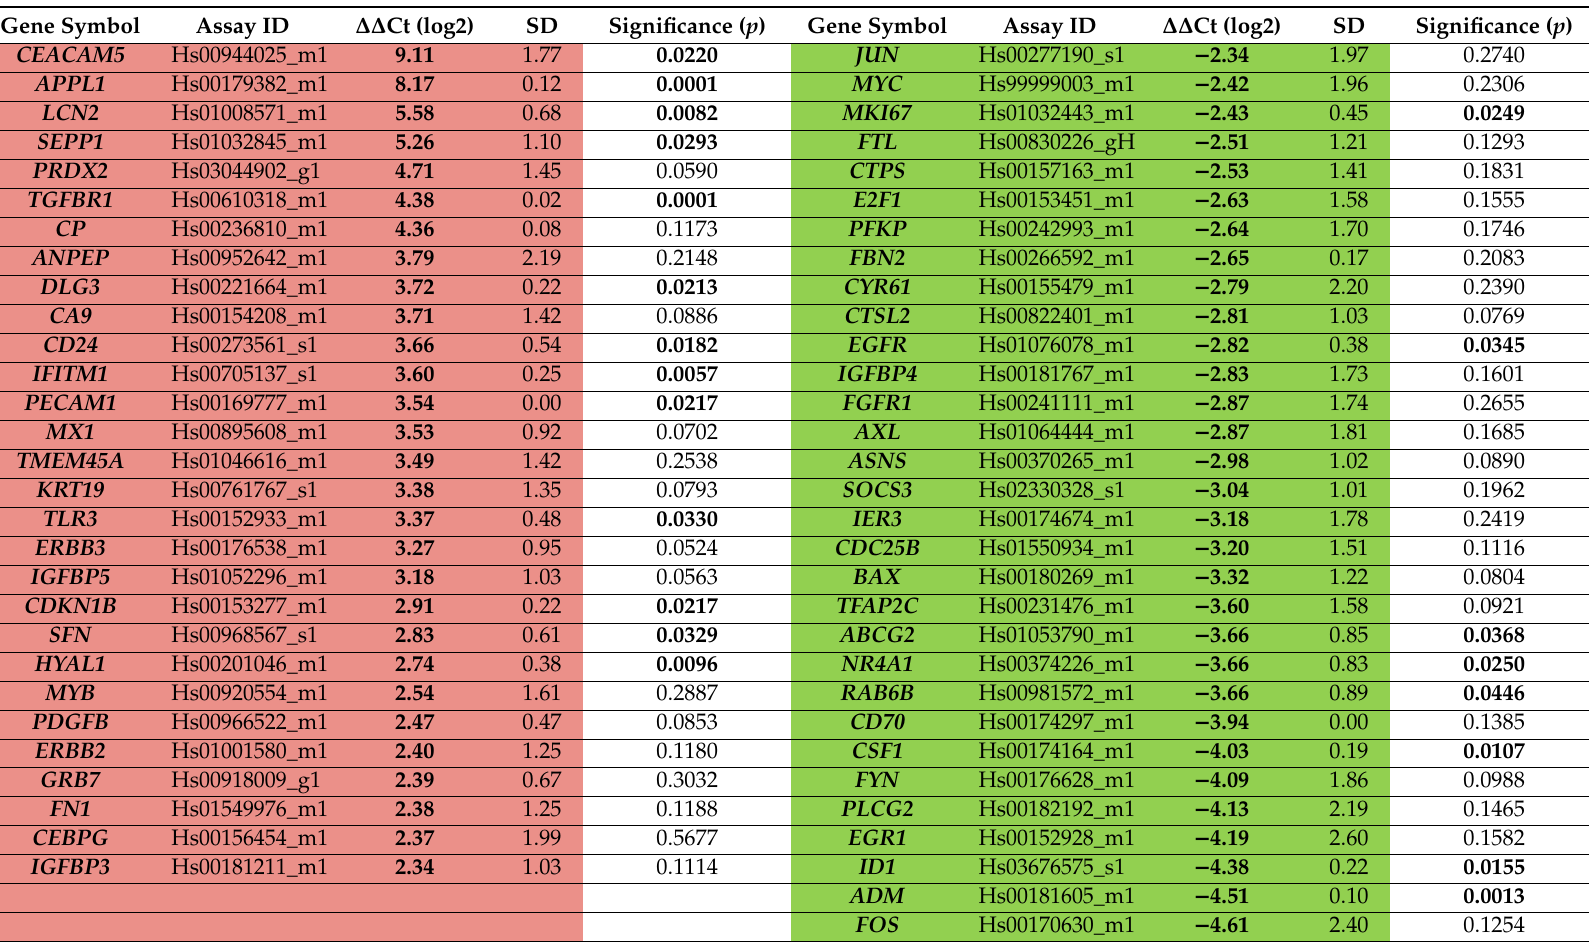
Table 2. Gene expression analysis by nanocapillary qRT-PCR of 624 genes (TaqMan ® OpenArray ® Human Cancer Panel, QuantStudio ™ 12K Flex) of A549 xenografts (in vivo) compared to 2D monolayer (Petri-dish) cultures resulted in the selection of sixty genes: 29 upregulated (pink) and 31 downregulated (green) for further studies. Significance ( p ) was calculated by Student’s t-test as pairwise comparison of ∆ Ct